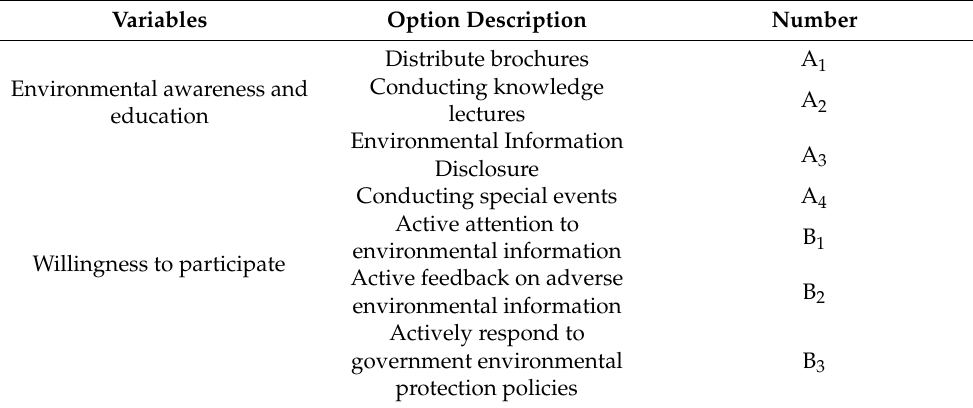
Table 1. Survey questionnaire scale